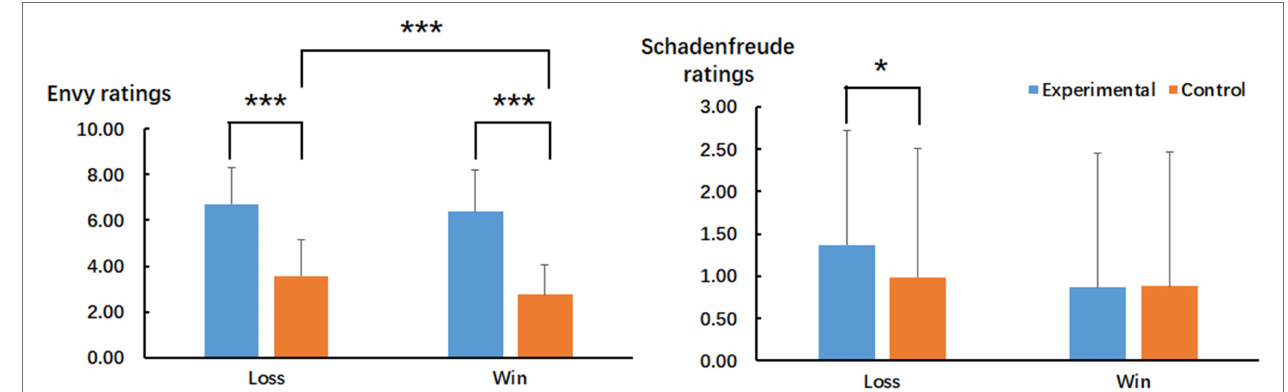
FIGURE 3 | Mean ratings of envy (the left panel) and schadenfreude (the right panel) for the interaction between emotion and block in Experiment 1. Vertical lines indicate the standard deviation of the means. The significance level of the emotional effect is marked by the number of the “*” symbol. * p < 0.05 and *** p < 0.001,